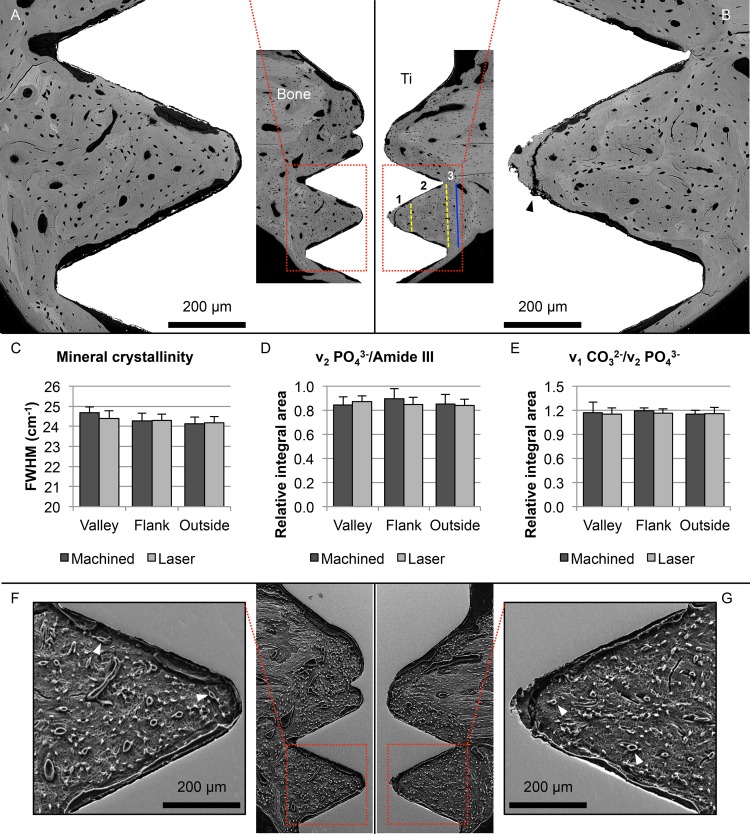
Backscattered electron scanning electron microscopy (BSE-SEM), Raman spectroscopy and resin cast etching.(A-B) BSE-SEM images of the (A) machined and the (B) laser-modified implants, showing mature, remodelled, osteonal, lamellar bone filling the implant threads. Following biomechanical testing (RTQ), bone detaches from the machined implant surface, resulting in a separation at the bone-implant interface, while a fracture line appears in the bone at some distance from the laser-modified implant surface (black arrowhead). (C-E) Raman metrics evaluated at the level of the first endosteal thread (as indicated in the insert image in B); 1: valley (corresponding to the inner 1/3 of the thread), 2: flank (corresponding to the outer 2/3 of the thread), 3: outside. (F-G) The same threads (as in A-B) are visualised following resin cast etching to confirm the presence of vasculature in the vicinity of the implant surface. The osteocyte lacuno-canalicular network (Ot-LCN) communicates with Haversian canals (white arrowheads), as well as extending towards the implant surface.